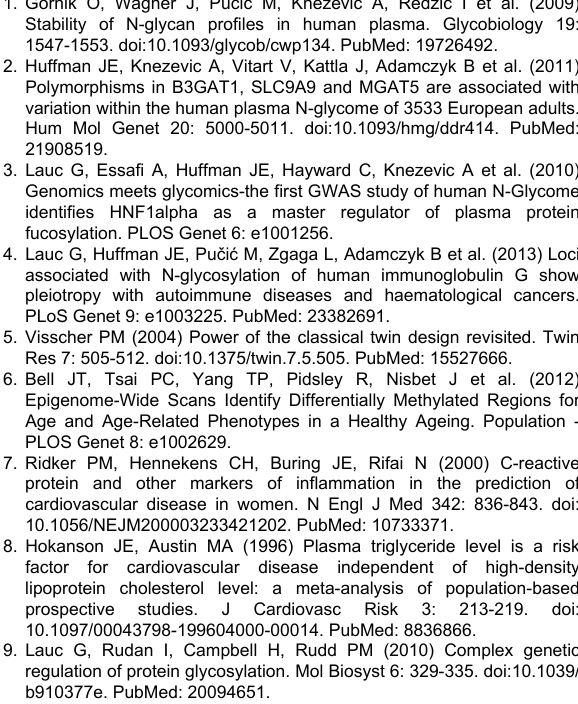
Table S2. List of glycans associated with circulating levels of triglycerides (log) and of C-reactive protein (Bonferroni P <7x10 -4 ).